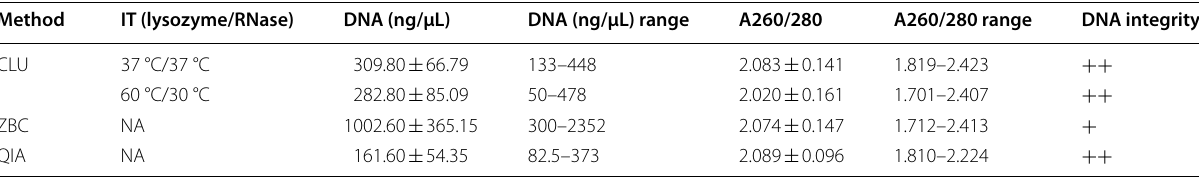
Values are represented as the mean clarity, density and presence of smearing NA not available, IT incubation temperature